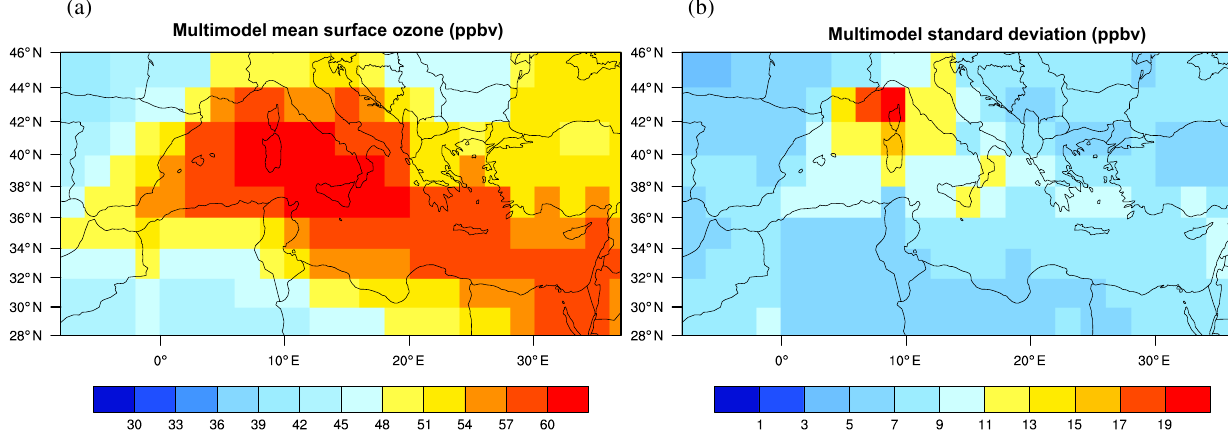
Figure 3. ACCMIP ensemble mean of surface ozone concentration in ppbv (a) and the ACCMIP ensemble standard deviation in ppbv (b) over the REF period (2000 time slice) from the historical experiment over the Mediterranean Basin. Red colors represent relatively high surface ozone concentration and large inter-model standard deviation for panels (a) and (b) , respectively. Blue colors represent relatively low surface ozone concentration and small inter-model standard deviation for panels (a) and (b) , respectively.